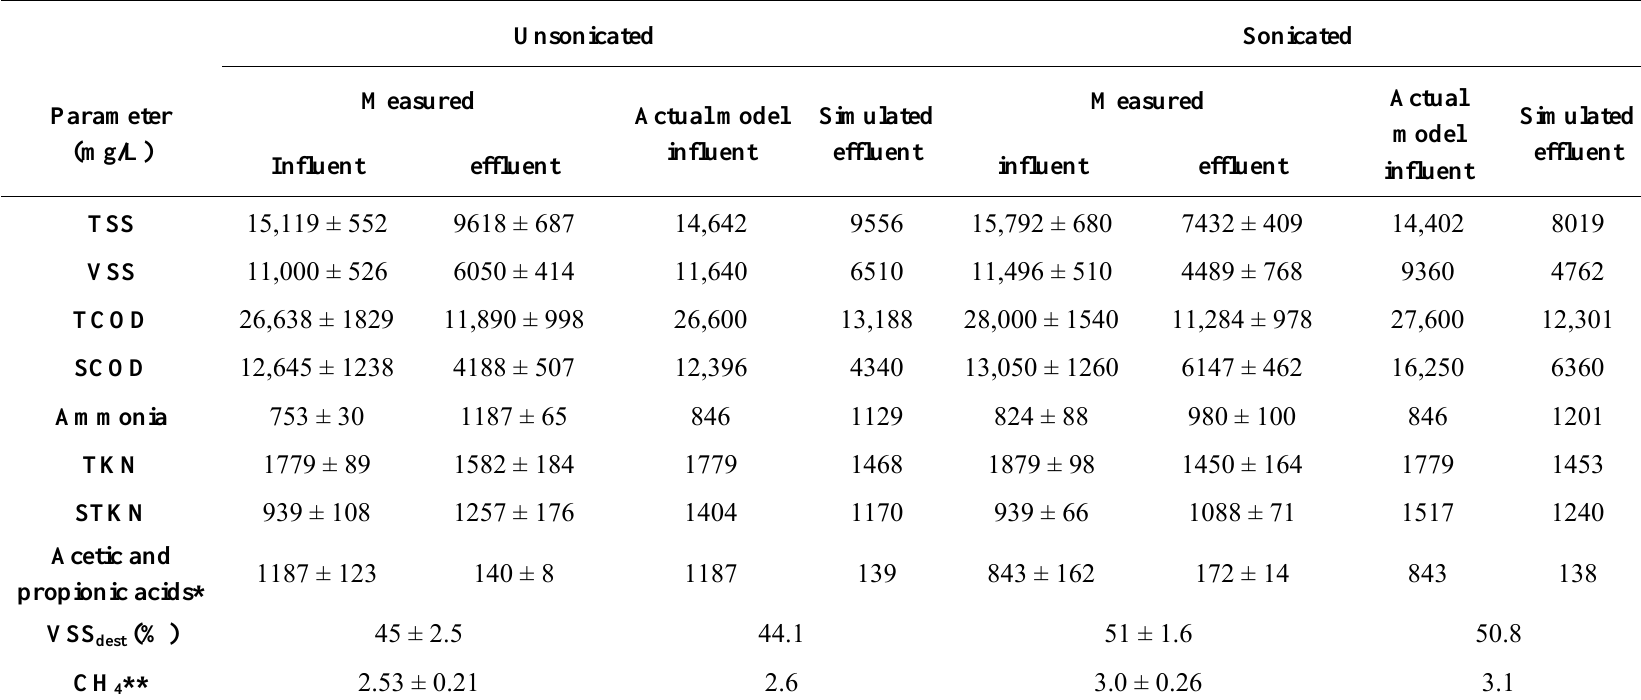
Table 2. Measured and simulated data using BioWin